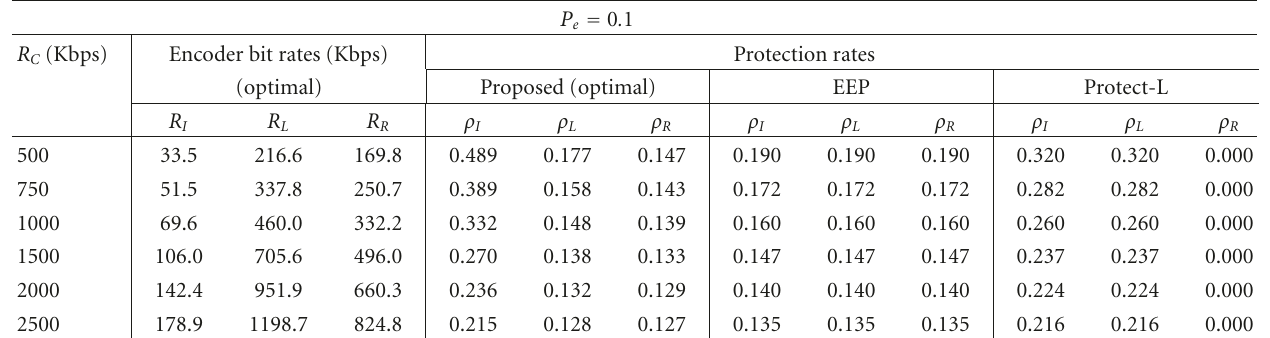
Table 3: Video encoder bit rates and Raptor encoder protection rates for “Rena” video. P e = 0 . 1